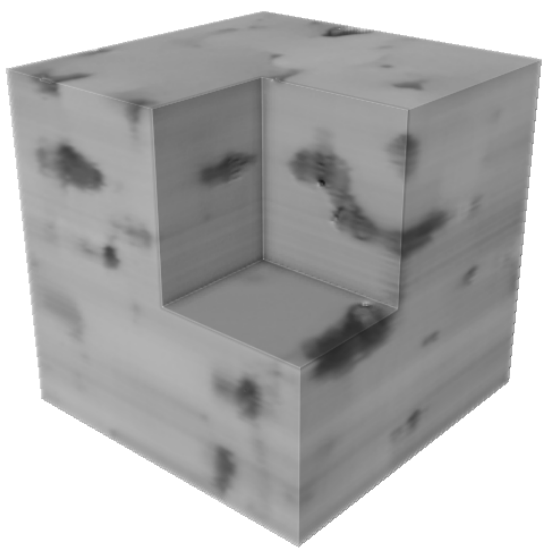
Figure 10. Volume rendering of synthetic FIB-SEM images with orthoslice cutouts shown. The images are trained on 128 × 128 pixel image patches and a 128 3 image volume is